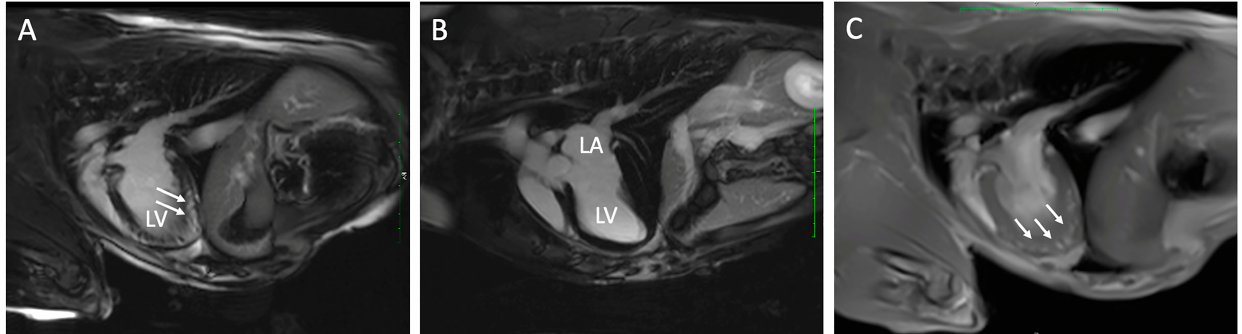
Figure 2. Cardiac magnetic resonance images from two dogs with chronic Chagas disease. In Panel ( A ), delayed myocardial enhancement (arrows) is demonstrated in the left ventricular (LV) apex compared to a dog without DME (Panel ( B )). Panel ( C ) is a FLASH Cine image three-chamber view in the same dog as panel ( A ) with DME that demonstrates loss of myocardial compaction at the LV apex (arrows). LA, left atrium.